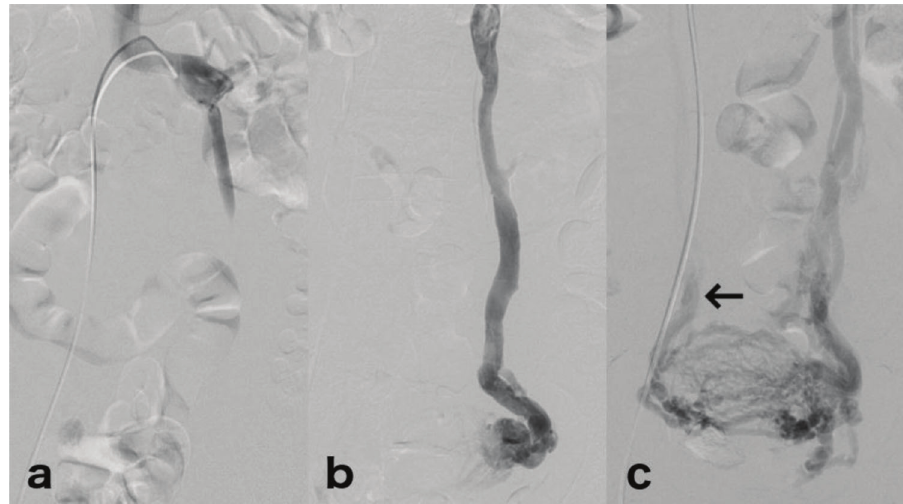
Figure 1 - Venography of three different patients, exemplifying reflux grades. (a) Selective left renal venography shows confined reflux in the left ovarian vein corresponding to grade I reflux. (b) Left ovarian venography shows reflux in the dilated left ovarian vein and periuterine veins corresponding to grade II reflux. (c) Left ovarian venography shows a dilated left ovarian vein and periuterine reflux extending across the midline (grade III reflux). Note the contrast material reaching the contralateral ovarian vein